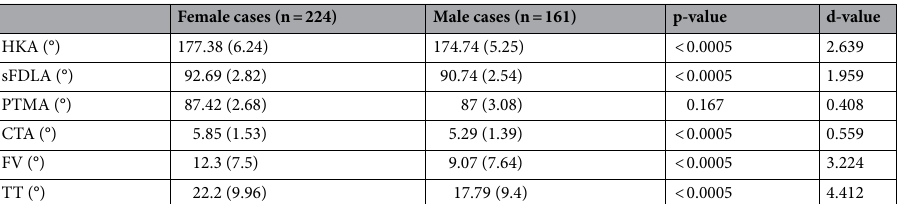
Table 2. Coronal and rotational parameters according to gender. Females differed significantly from males in the hip-knee-ankle angle and in the supplementary angle of the femoral lateral distal angle and presented higher femoral external rotation, femoral anteversion and tibial external rotation (independent two-sample t-test). Angular values expressed as the mean and (standard deviation). CTA, condylar twist angle. FV, Femoral Version measured between the femoral neck axis and the posterior condylar line. HKA, hip-knee-ankle angle. PTMA, proximal medial tibial angle. sFDLA, supplementary angle of the femoral lateral distal angle. TT, Tibial Torsion. d-value to qualify the magnitude of an effect (the difference between means) can be interpreted according to the criteria by Hopkins et al. 21 : less than 0.2, trivial; 0.2 to 0.59, small; 0.6 to 1.19, moderate; 1.20 to 2, large; 2 to 3.99, very large, and greater than 4, extremely